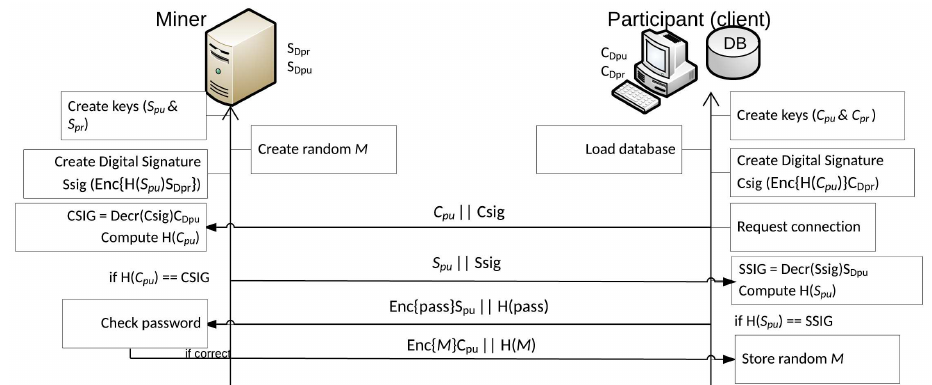
Figure 3. Key generation and mutual authentication phases.